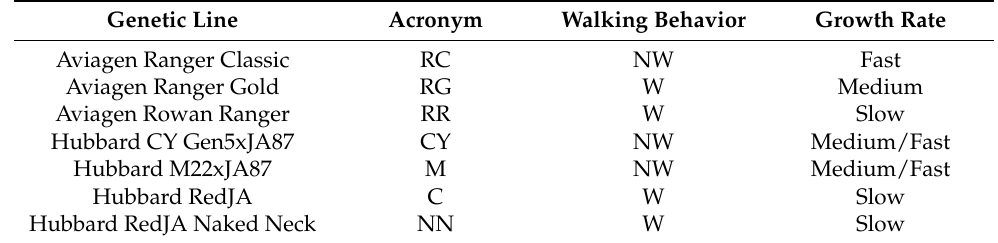
Table 1. Genetic lines analyzed, walking behavior (W: Walking; NW: Not-Walking), and growth rate. Genetic Line Acronym Walking Behavior Growth Rate Aviagen Ranger Classic RC NW Fast Aviagen Ranger Gold RG W Medium Aviagen Rowan Ranger RR W Slow Hubbard CY Gen5xJA87 CY NW